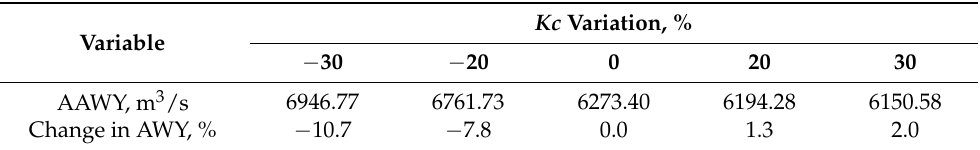
Table 4. Annual average water yield (AAWY) variation in 2018 using different variation of the Kc coefficient.